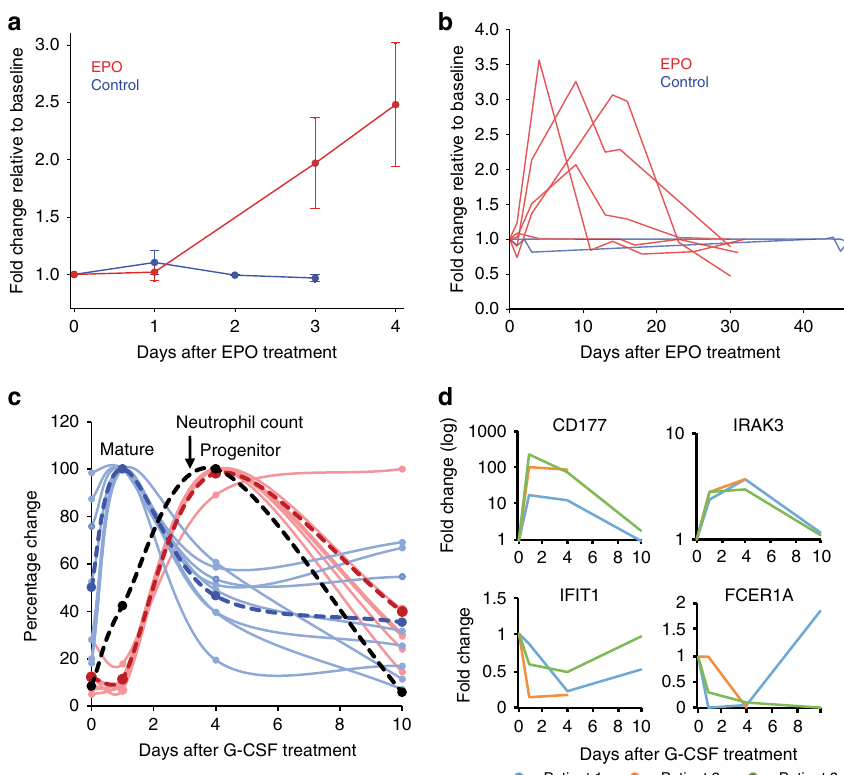
Fig. 5 cf-mRNA captures the transcriptional activity of hematopoietic lineages upon stimulation. a Blood was obtained from nine patients before (day 0) and after being treated with a single EPO dose (see Methods). Gene expression patterns in plasma cf-mRNA were analyzed using RNA-Seq. Day 0 (before EPO treatment) was used as reference for each patient, and changes in the levels of erythrocyte-speci fi c transcripts after EPO treatment calculated. Average fold change of erythrocyte transcripts in all n = 9 patients subjected to EPO treatment (red) and n = 3 untreated controls (blue) are shown. Error bars represent standard error (SE). Source data are provided as a Source Data fi le. b Time-course analysis of erythrocyte transcripts over a 30 day period in EPO-treated patients (red). Each line represents a patient, and shows average fold change of erythrocyte transcripts over time after a single EPO dosing administered at day 0, which is used as reference. Blue lines show fl uctuations of the same transcripts in untreated healthy controls. c Blood was obtained from three healthy patients treated with G-CSF (before treatment (day 0), and 1, 4 and 10 days after treatment). Changes in circulating transcriptome were analyzed by cf-mRNA sequencing. Relative changes of immature (red) and mature (blue) neutrophil-speci fi c transcripts throughout the study are shown for a representative patient treated with G-CSF. Dashed red and blue lines indicate the average for each group of transcripts. Relative changes in neutrophil counts are shown in black. Source data are provided as a Source Data fi le. d Time course of indicated G-CSF-responsive genes measured by cf-mRNA-Seq. Plots show fold change over time relative to day 0. Time points are connected by lines, each line represent a